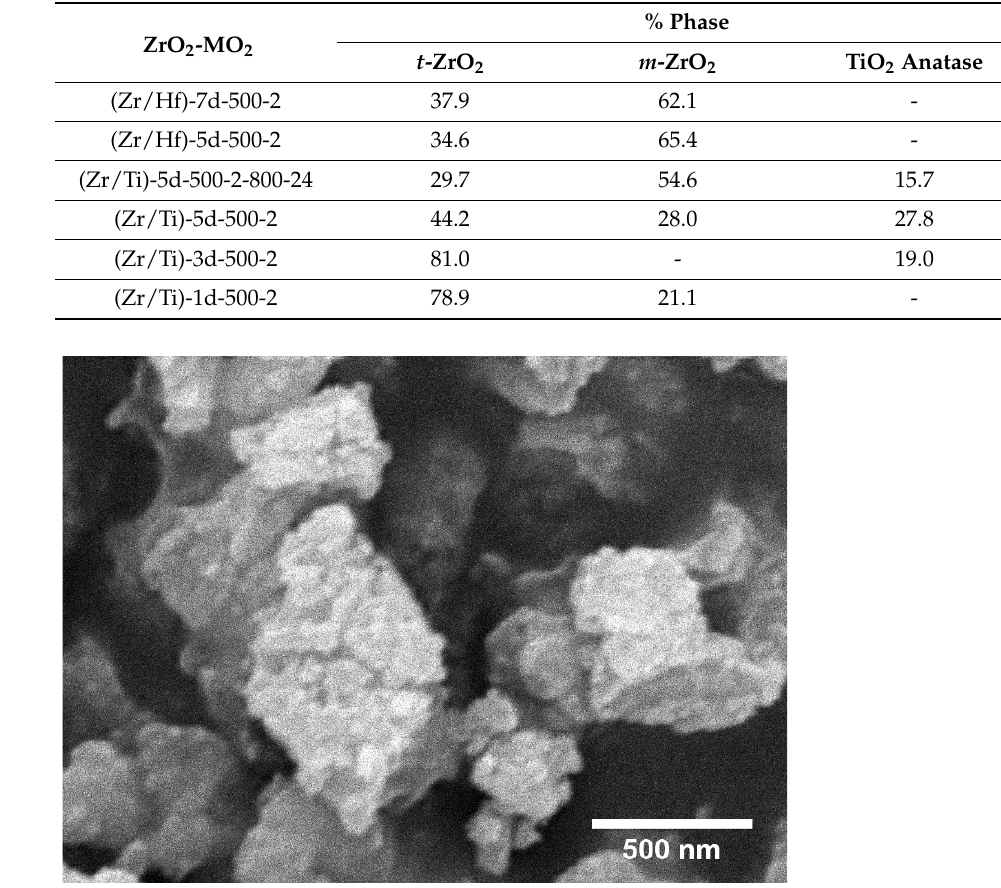
Figure 3. PXRD patterns of ZrO 2 -TiO 2 and ZrO 2 -HfO 2 composites.